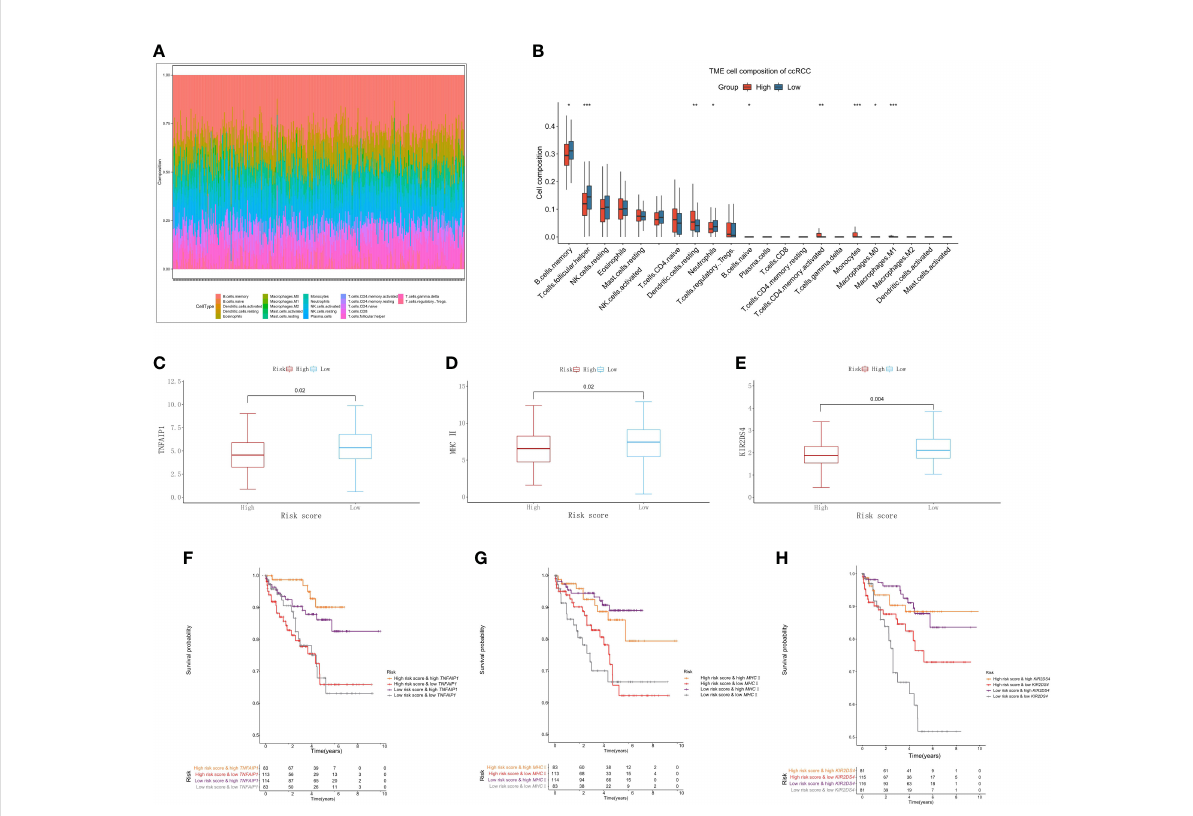
FIGURE 7 Immune cell in fi ltration associated with the risk score in ccRCC. (A) The abundance ratios of 22 immune cells in the TCGA-KIRC cohort. (B) Differences in immune cell abundance between the high-risk and low-risk groups. Relationship between the risk score and the immune activators TNFAIP1 (C) , MHC II (D) , and KIR2DS4 (E) . Relationship between the risk score and the expression of the immune activators TNFAIP1 (F) , MHC II (G) , and KIR2DS4 (H) with